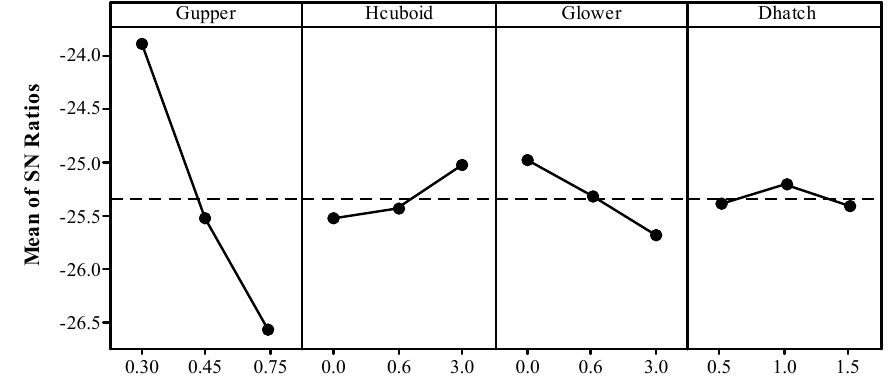
Figure 12. Main effects plot for S / N R ratio.